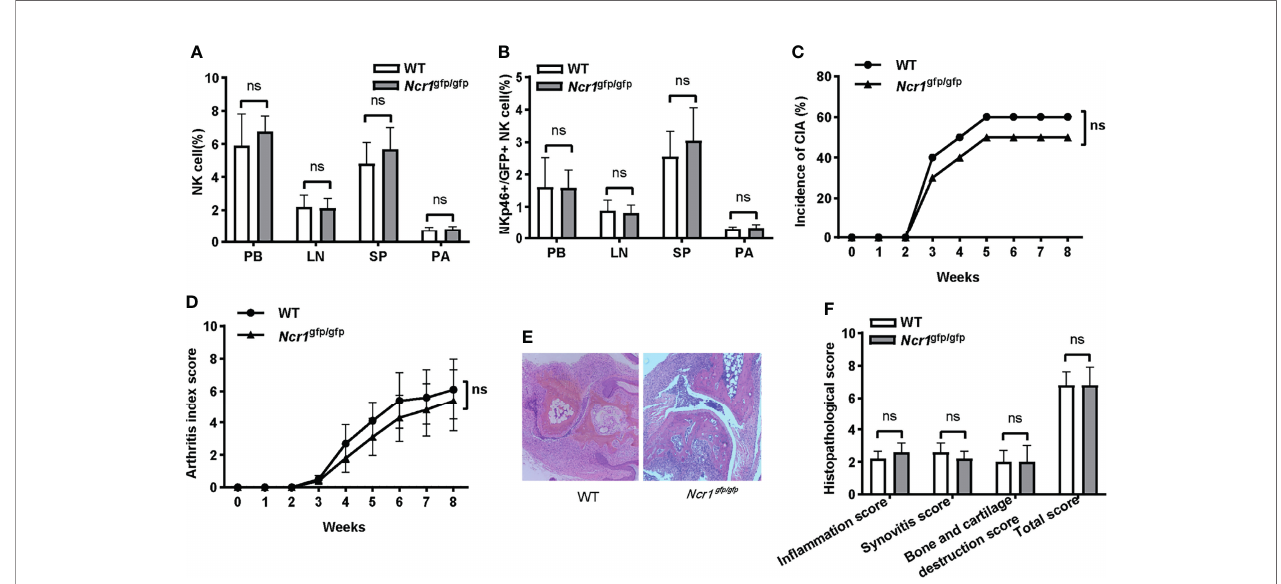
FIGURE 6 | The impact of NKp46 de fi ciency on the incidence and severity of arthritis in CIA mice. (A, B) Frequencies of NK and NKp46 + /GFP + NK cells in wild-type C57BL/6 and Ncr1 gfp/gfp mice among different tissues. Student ’ s t-test; n = 5 per group. (C) Incidence of arthritis in wild-type C57BL/6 and Ncr1 gfp/gfp mice. Log- rank test, n = 10 per group. (D) Arthritis index score in wild-type C57BL/6 and Ncr1 gfp/gfp mice. Two-way repeated measures ANOVA. There is no signi fi cant group nor a time (week) × group effect. n = 10 per group. (E, F) Representative histological staining (H&E, ×100 magni fi cation) and histopathological analysis between wild- type C57BL/6 and Ncr1 gfp/gfp mice. Mann – Whitney U test for comparison of in fl ammation score, synovitis score, and total score; Student ’ s t-test for bone and cartilage destruction score; n = 5 per group. PB, peripheral blood; LN, lymph nodes; SP, spleen; PA, paws; ns, not signi fi cant. Results are representative of three independent